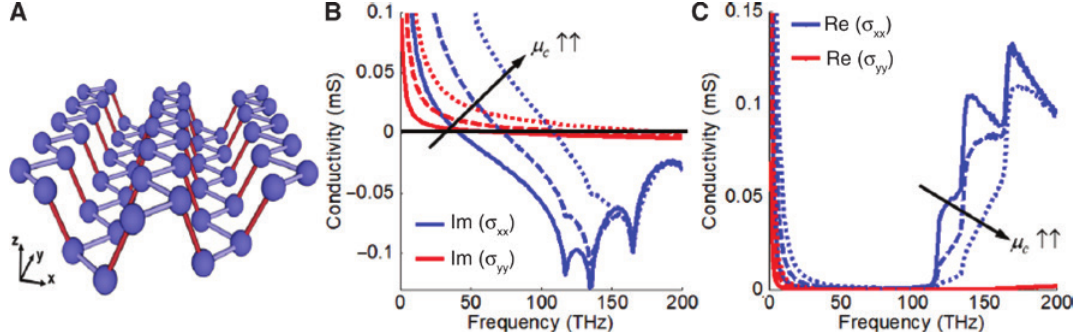
Figure 8: Naturally anisotropic 2D materials: the case of black phosphorus (BP). (A) Lattice structure of monolayer BP. Different colors are used for visual clarity. (B) Imaginary part of BP conductivity components versus frequency for several values of chemical potential. (C) Real part of BP conductivity components versus frequency for several values of chemi- cal potential. Solid, dashed, and dotted lines correspond to chemical potentials of 0.005, 0.05, and 0.1 eV, respectively. The considered BP thickness is 10 nm, its direct band gap is 0.485 eV, damping 5 meV, at a temperature of 300 K. Adapted with permission from Ref.